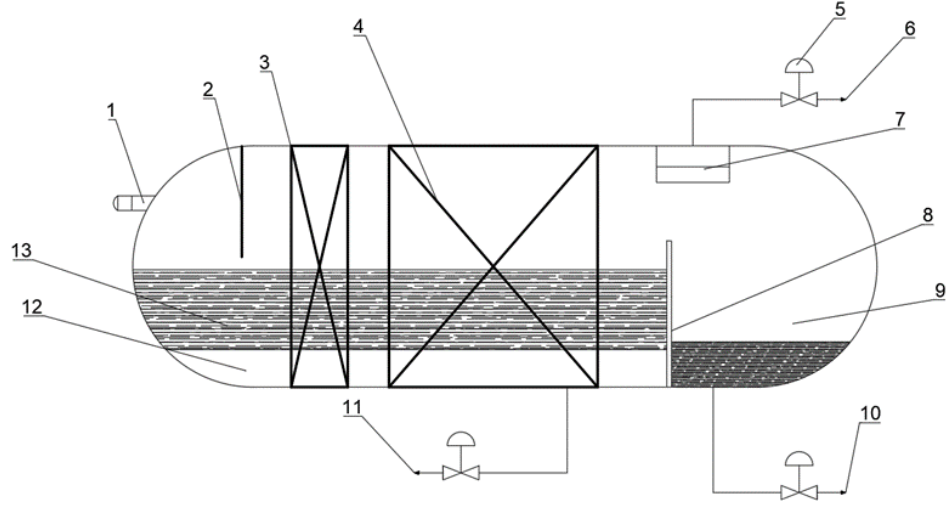
Figure 1. Structural diagram of horizontal three-phase separator. 1 — oil and gas water mixture inlet; 2 — inlet member; 3 — rectifying member; 4 — coalescence member; 5 — pressure control valve; 6 — gas phase outlet; 7 — capping; 8 — oil baffle; 9 — oil room; 10 — oil phase exit; 11 — aqueous outlet; 12 — water; 13 — oil and emulsion.